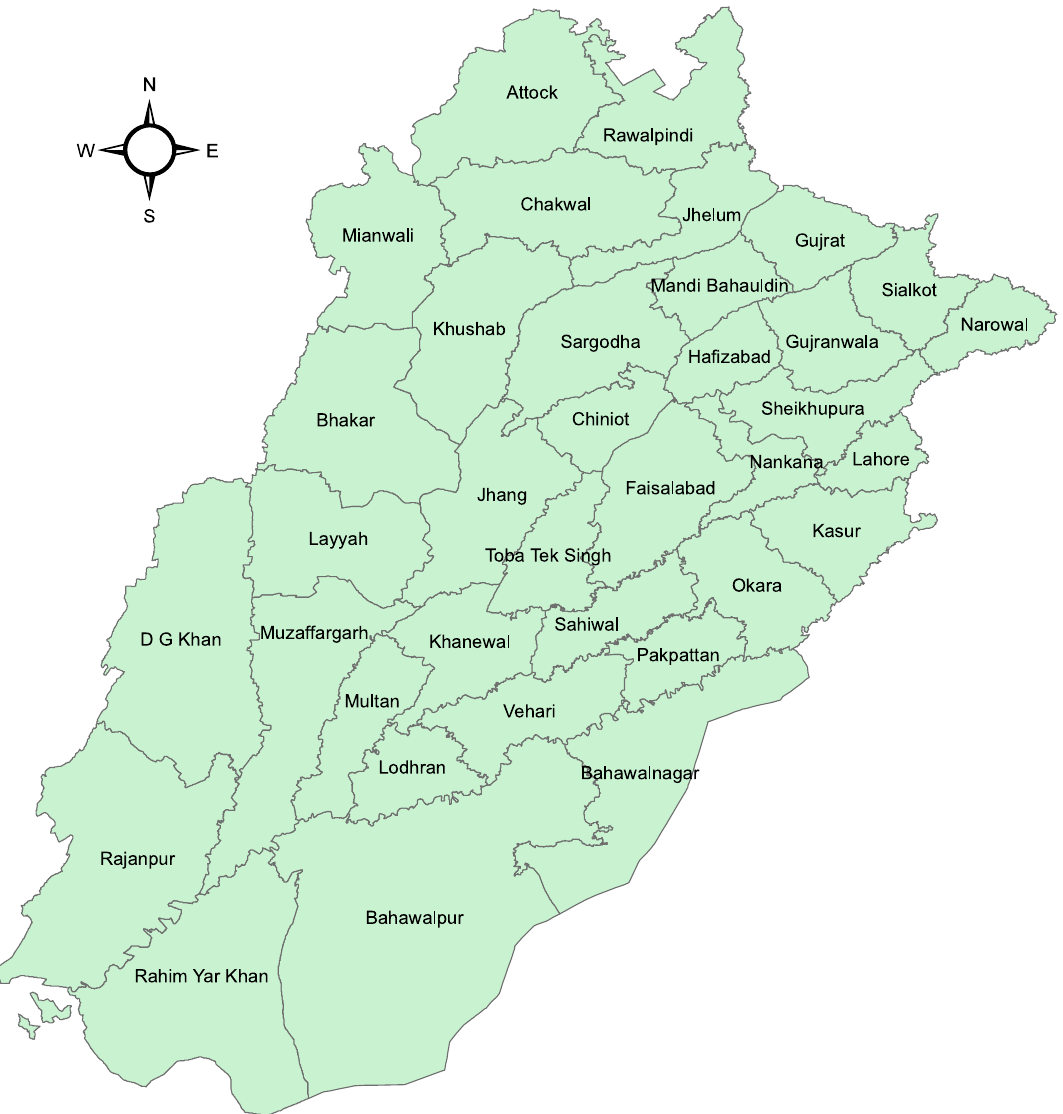
Figure 1. Map of province Punjab, Pakistan. Source Generating using Arc GIS version